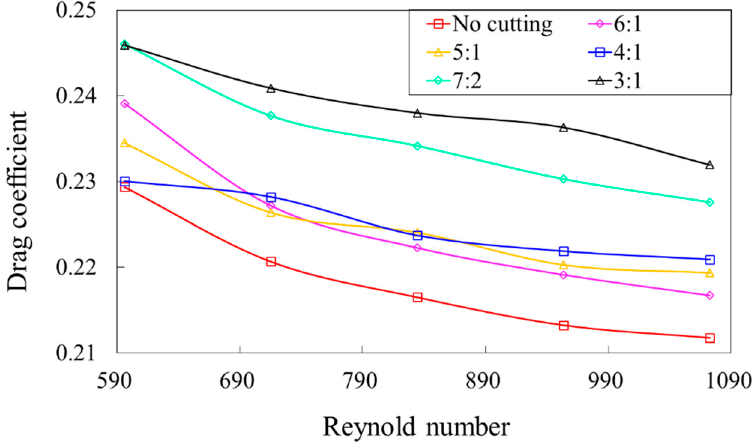
Figure 7. Drag coefficient of empty codends with different cutting ratio at five current speeds.